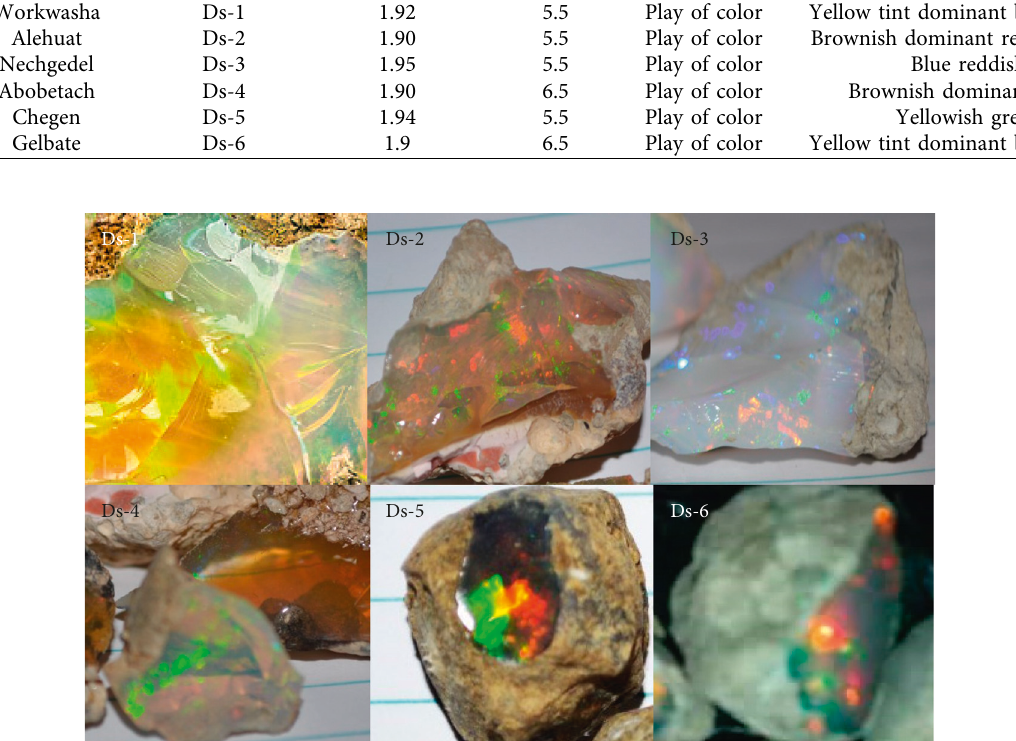
Figure 1: Photograph images of opal samples mined from different mining sites at Delanta district: (a) Ds-1, (b) Ds-2, (c) Ds-3, (d) Ds-4, (e) Ds-5, and (f) Ds-6.